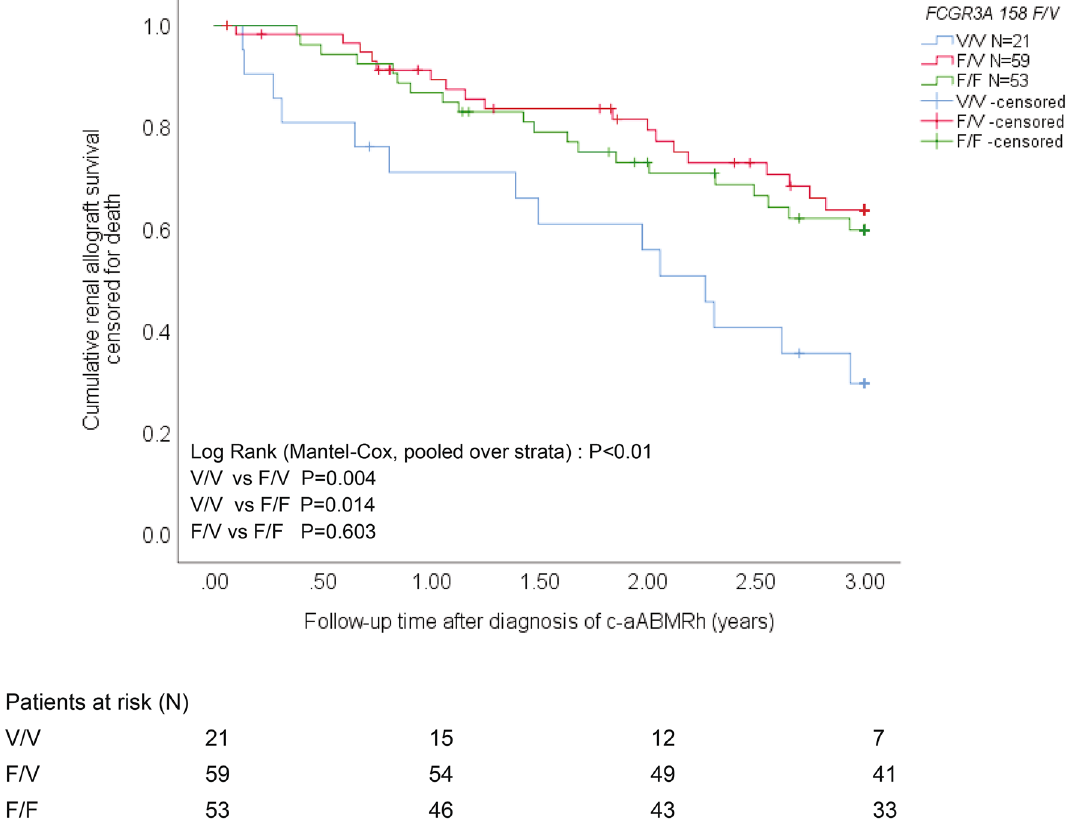
Figure 3. FCGR3A 158 F/V-genotype and renal allograft survival in c-aABMRh kidney transplant recipients. The c-aABMR-related allograft survival censored for death is depicted for the different FCGR3A 158 F/V- genotypes. Overall pooled over strata P value and P values for the difference between the different strata (genotypes) were calculated by Mantel–Cox log-rank statistical analysis. P values < 0.05 were considered statistically significant (blue, red and green lines represent allograft survival for V/V-, F/V- and F/F-genotype, respectively). At start and at 1, 2 and 3 years of follow-up, the number of kidney transplant recipients at risk are depicted for the different FGCR3A 158